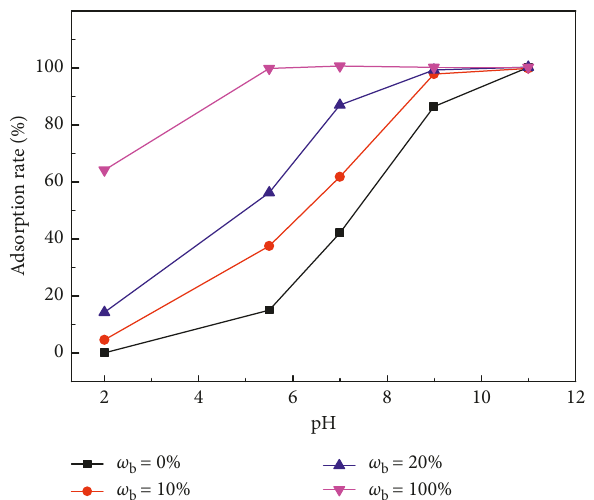
Figure 4: Influence of pH on Pb(II) adsorption ( s / w